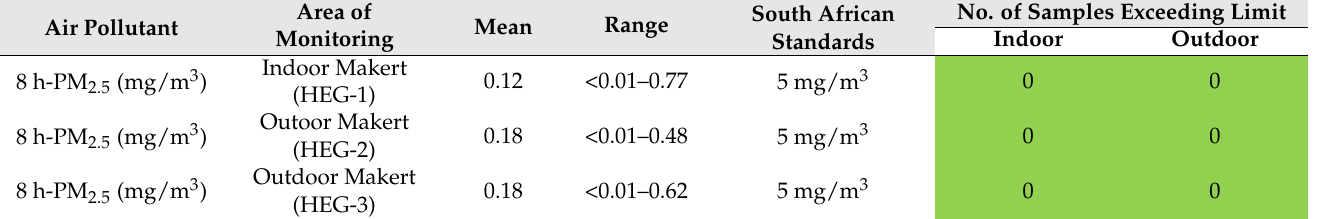
Table 2. Descriptive statistics of TWA PM 2.5 concentrations of informal cooking vendors in the inner city of